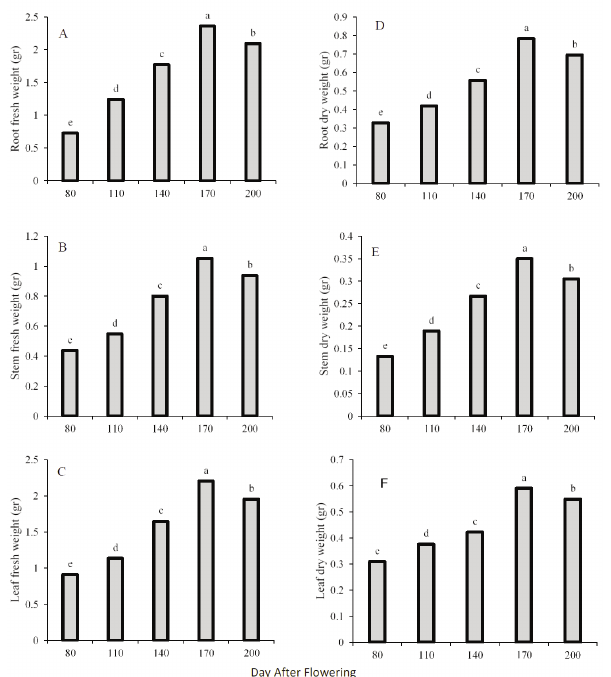
Fig. 6 ­ Effect of harvest time on seedlings root, stem, and leaf fresh weight A­C and dry weight (D­F) of Mexican lime. Means with the same letter are not significantly different at 1% probability using LSD